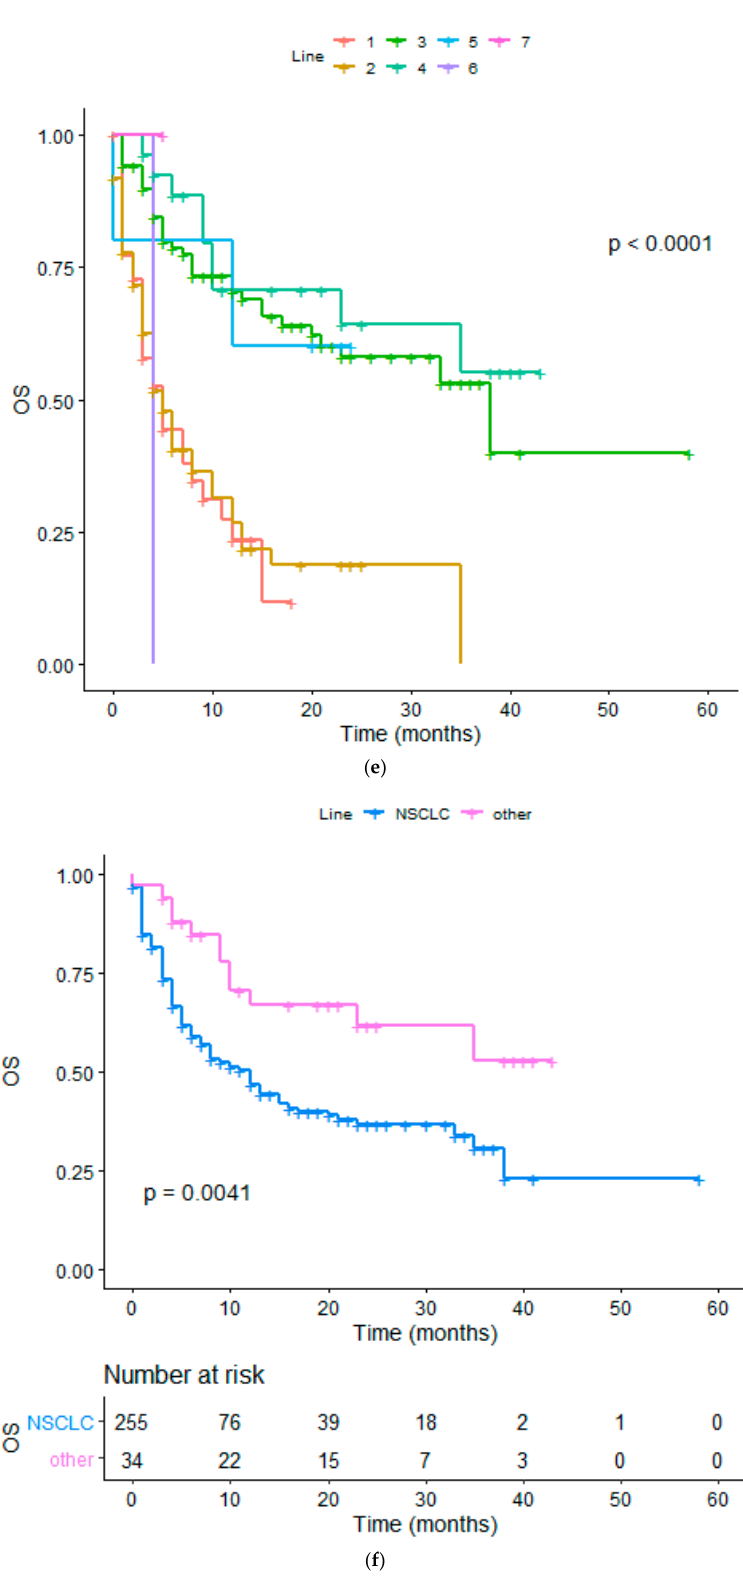
Figure 1. ( a ) OS in patients with and without liver metastases; ( b ) OS in patients with and without brain metastases; ( c ) OS in patients with and without bone metastases; ( d ) OS in patients treated with immunotherapy upfront or in subsequent lines; ( e ) OS in di ff erent histologies; ( f ) OS in patients a ff ected by squamous and non-squamous NSCLC or other